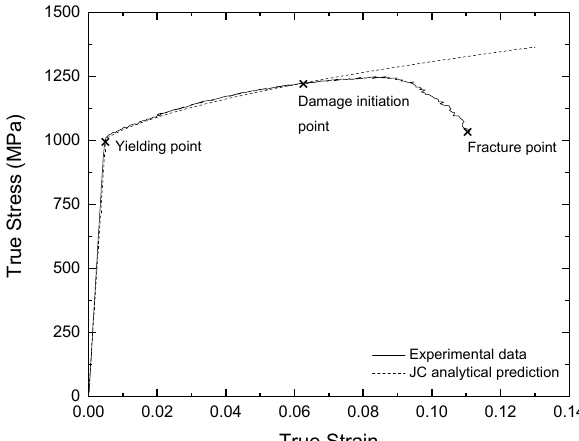
Figure 10. Comparison of true stress–strain curve between experimental data and JC analytical prediction.